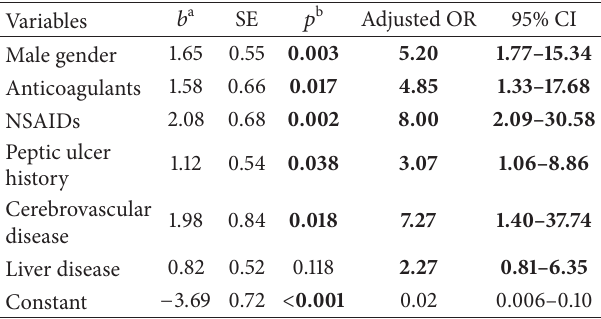
Table 3: The final multivariable logistic